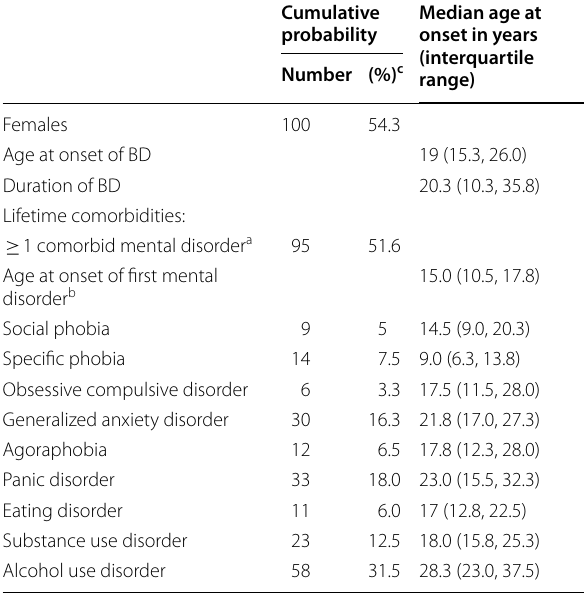
Table 2 Characteristics of 184 individuals with BD-I (92 sex- matched proband-parent